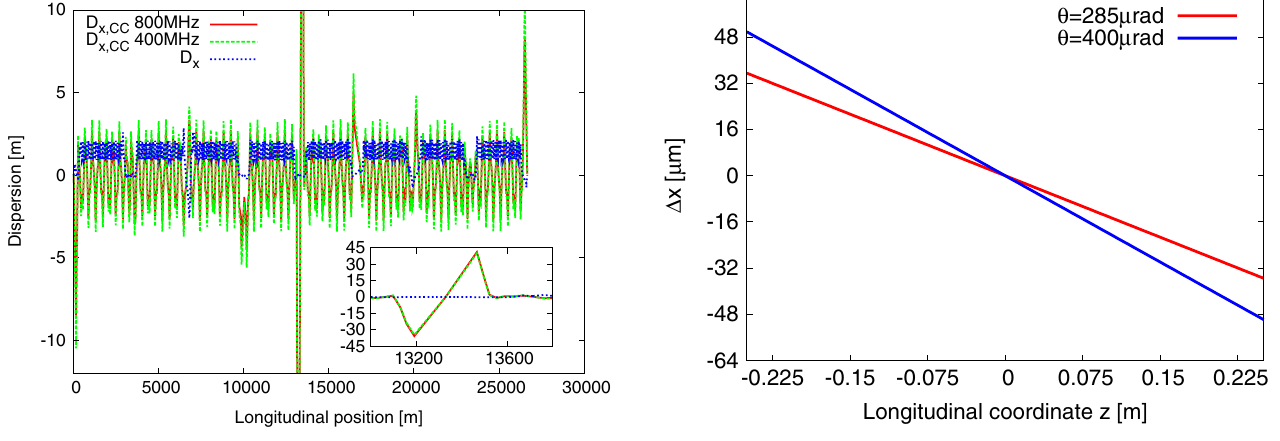
FIG. 2. (Color) Crab dispersion and off-momentum dispersion for lowbetamax collision optics.